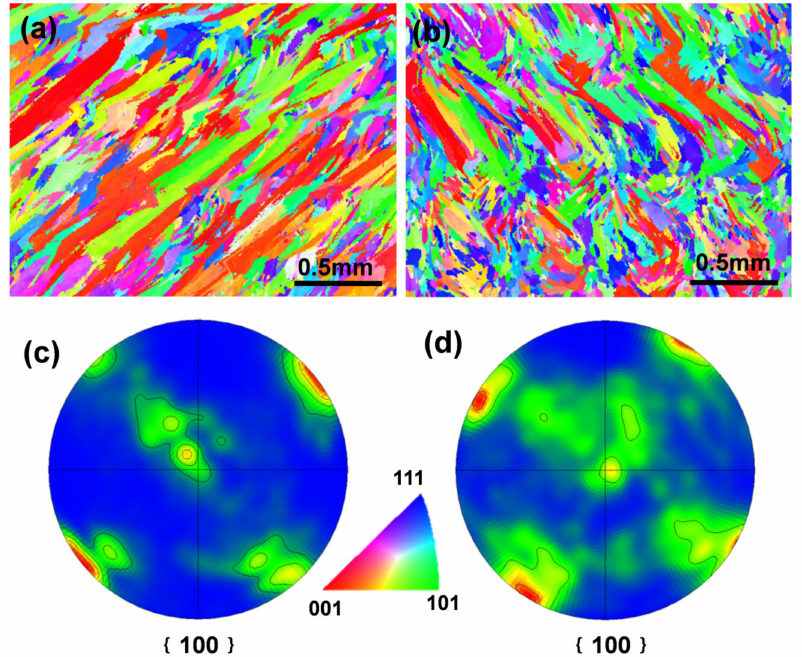
Figure 3. Electron back scatter diffraction (EBSD) maps of as-fabricated samples: ( a ) Inverse pole figure (IPF) colored orientation image map (OIM) and ( b ) OIM map of CDS sample, ( c ) (100) pole figure of SDS sample and ( d ) (100) pole figure of CDS